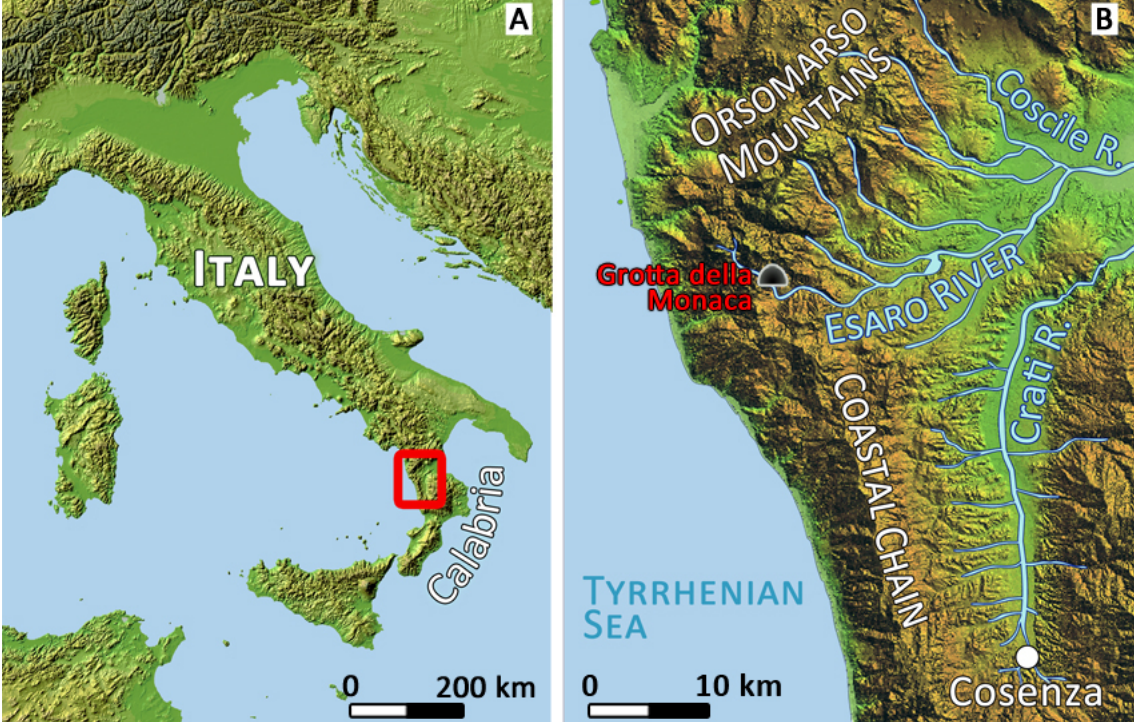
Figure 1. A. Location of Grotta della Monaca's area within the Italian peninsula. B. Overview map of the river Esaro